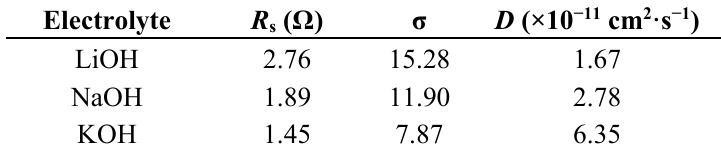
Table 1. Impedance parameters evaluated from electrochemical impedance spectroscopy